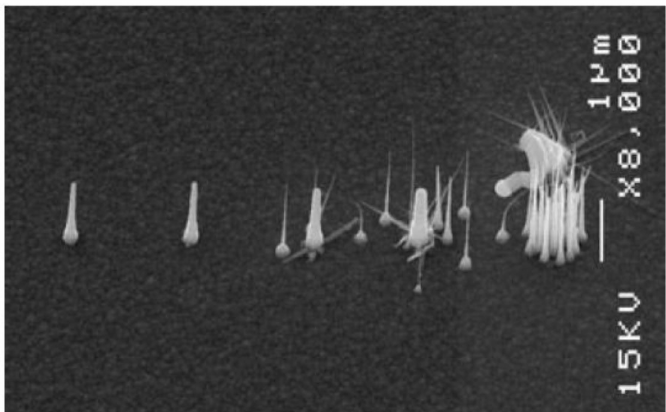
Figure 8. Scanning electron micrographs of InP nanowires grown from gold catalysts with different thickness-to-height ratios, showing the role of the catalyst’s aspect ratios in determining the properties of the grown NW array. The metal pattern realized on the substrate prior to growth consisted of five gold disks with a fixed thickness of 17 nm and varying diameters. Starting from the left, the catalyst diameters were: 50, 100, 200, 400, and 800 nm, corresponding to gold catalysts thickness-to-height ratios of about 1/3, 1/6, 1/12, 1/24, and 1/47. As shown in the image, for thickness-to-height ratios of 1/3 and 1/6, each individual catalyst originates a single nanowire. For lower aspect ratios, the catalysts are unstable and tend to split into many small catalyzing particles, giving rise to the growth of multiple inhomogeneous nanowires. (Reprinted with permission of Ref.